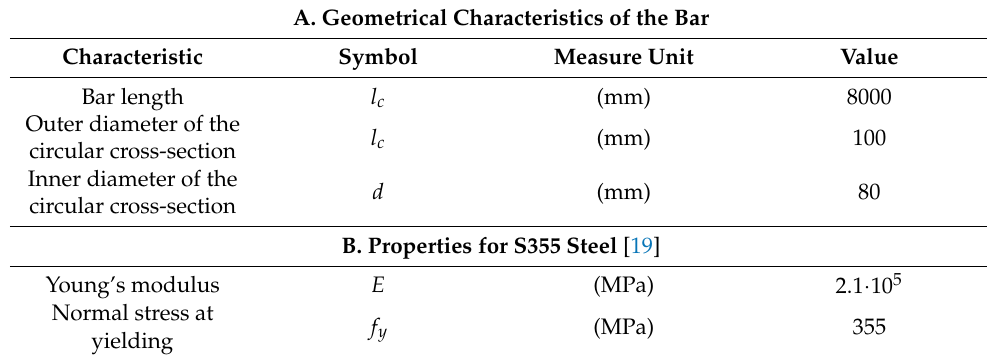
Table 1. Geometrical characteristics and material properties for the bar analyzed by numerical modeling.